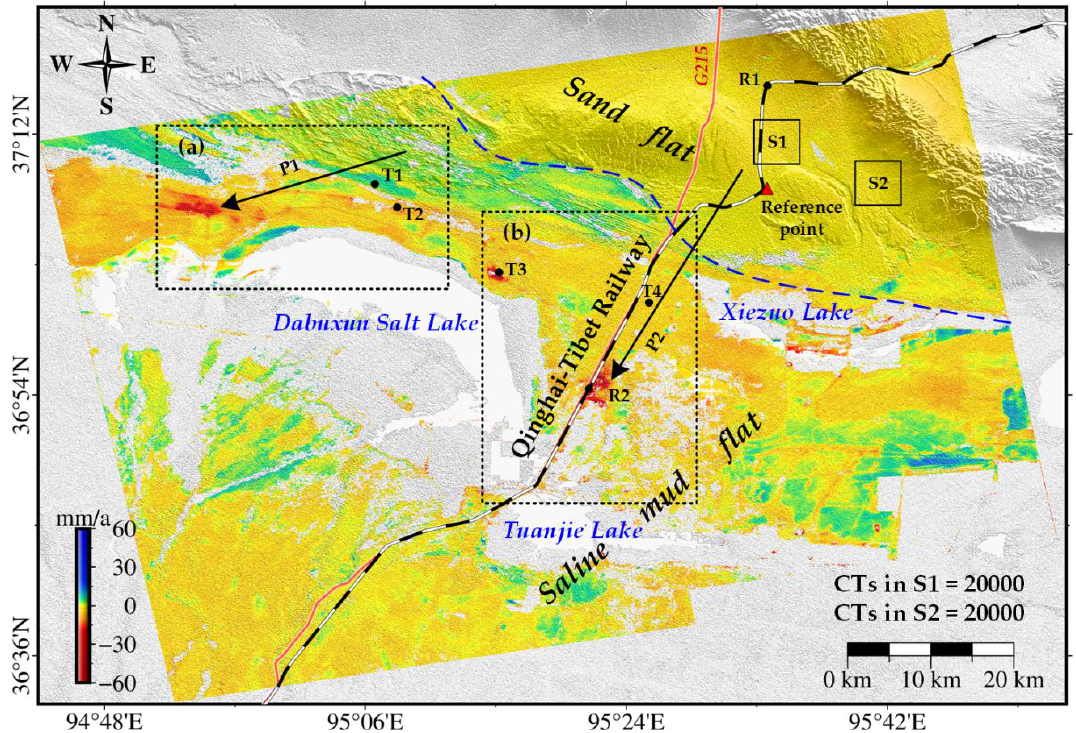
Figure 7. The deformation velocity map derived by the improved TS-InSAR with the temporal baseline of 49 days or ASC of